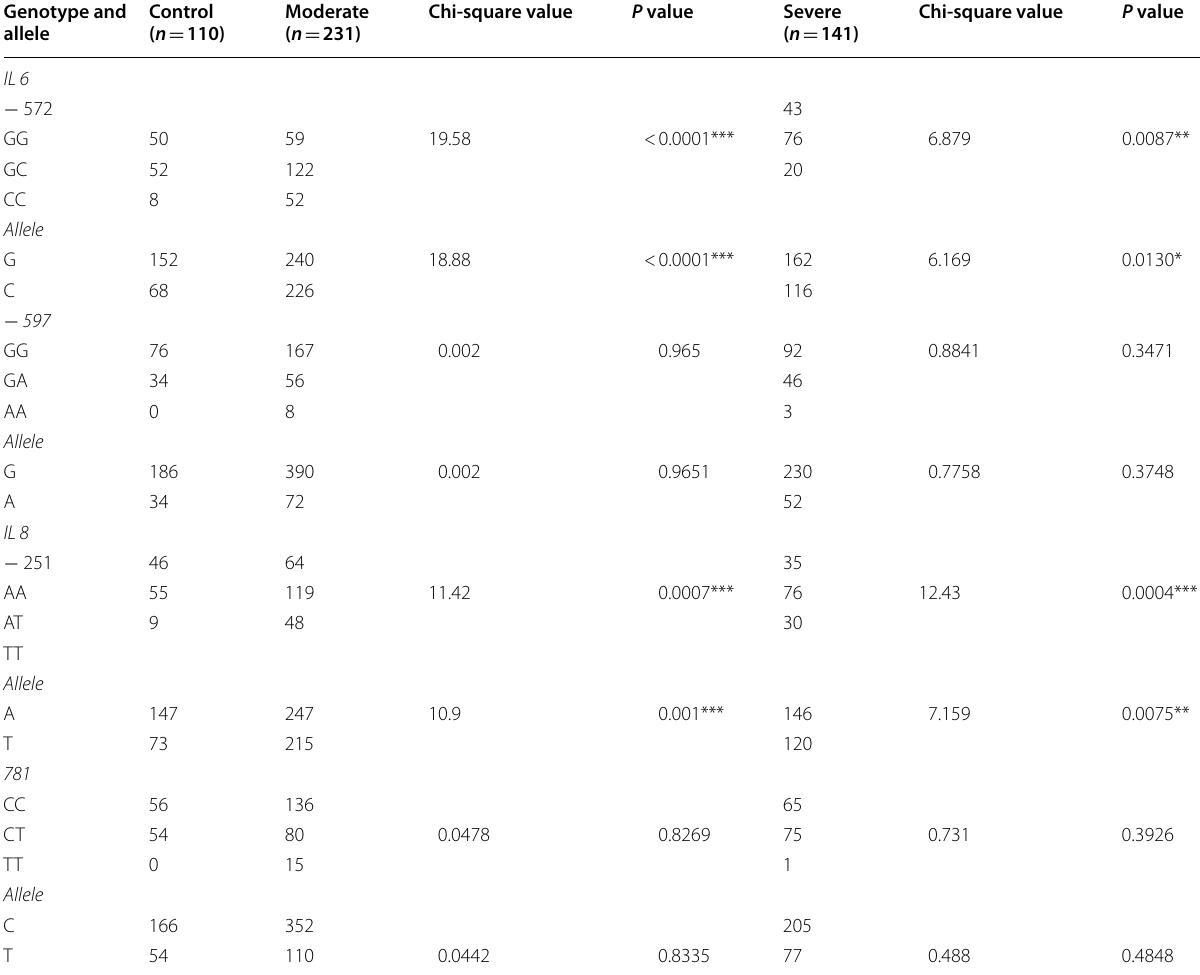
Table 4 Association of IL 6 and IL 8 gene polymorphisms with the severity of HDM sensitization (** signifies p < 0.001, *** signifies p < 0.0001 and values are significant) Genotype and